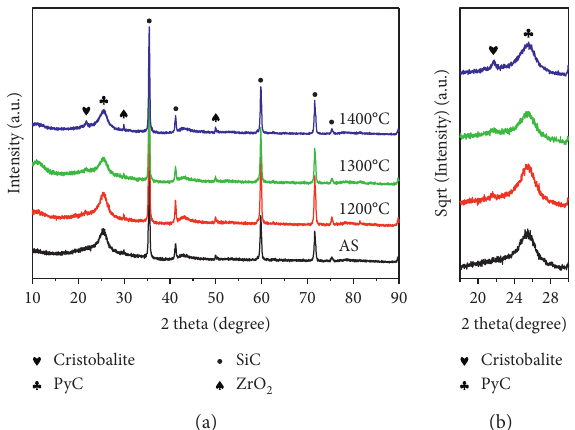
Figure 4: XRD patterns of TRISO particles. (a) Both as-deposited sample and the samples after air oxidation for 24h at 1200 ° C–1400 ° C and (b) amplified XRD patterns from 18 ° –30 °